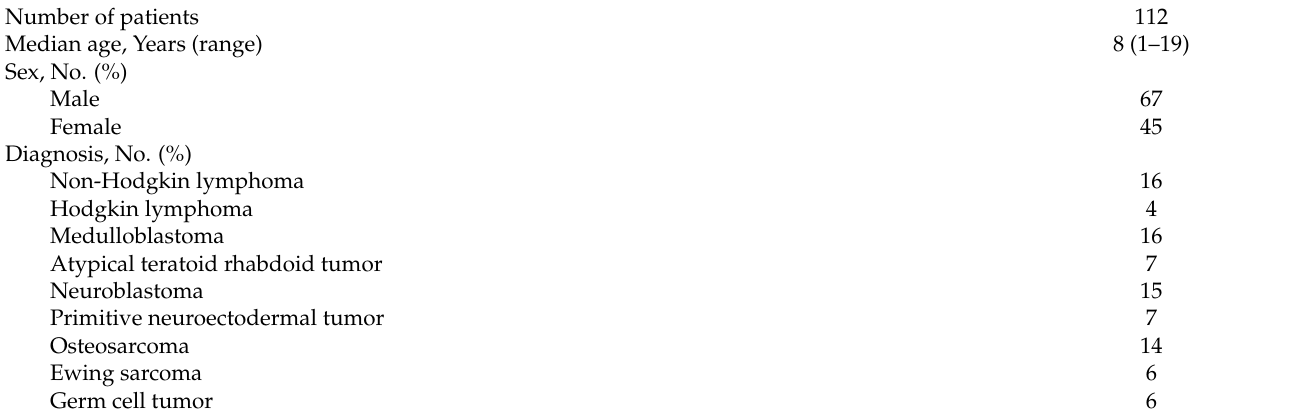
Table 1. Characteristics of the